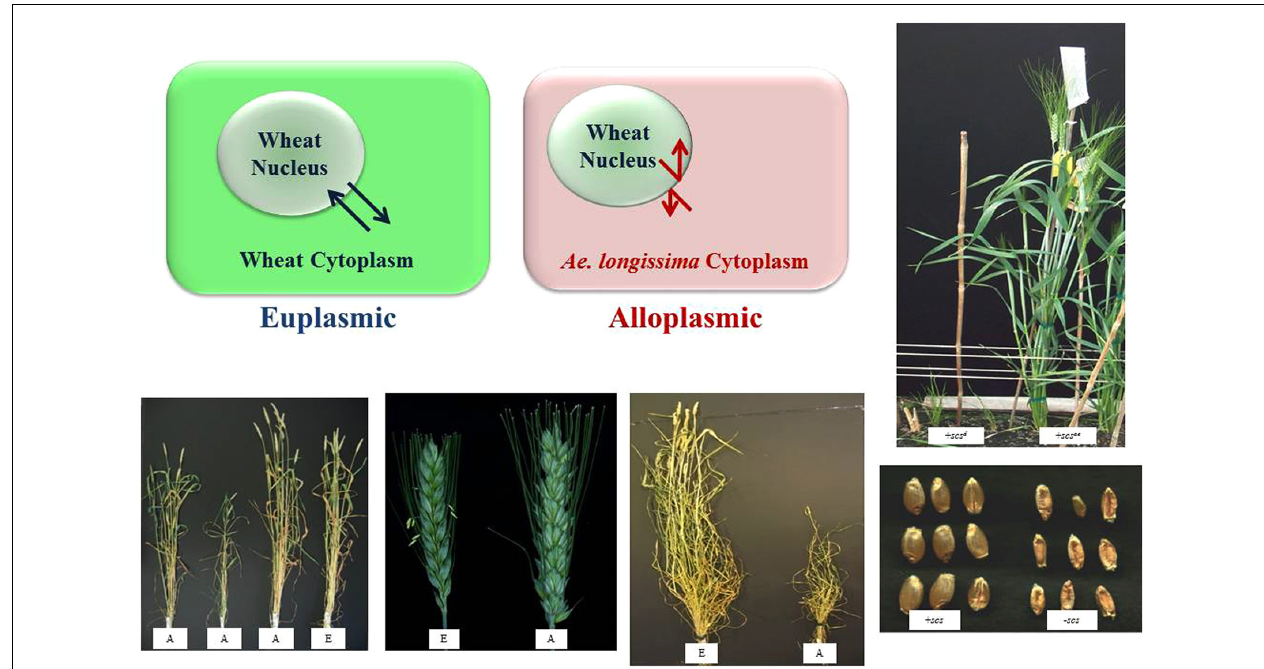
FIGURE 1 | Examples of euplasmic and alloplasmic wheat lines. Top part of the figure is a diagrammatic representation of a euplasmic (true cytoplasm) and alloplasmic (alien cytoplasm, e.g., Aegilops longissima ) lines of wheat. Euplasmic communication can take place between nucleus and cytoplasm as indicated by the arrows. Alloplasmic communication between nucleus and cytoplasm can be disrupted as indicated by opposing arrows. Bottom part of the figure provides